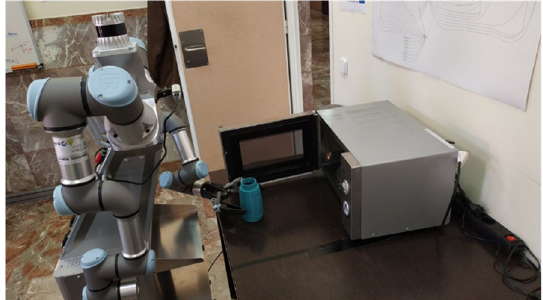
Figure 23. Manipulator robot inserting the cup of coffee into the microwave.